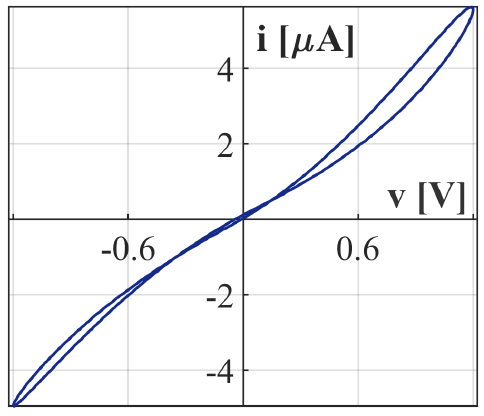
Fig. S1 | Alternating current (AC) voltage-current plot of subject B at the earlobe , shown for the third period of applied sinusoidal voltage with frequency of 0.05 Hz and amplitude of 1.2 V. These data (not shown before) are obtained from the experiment presented in [22]. The two pinched points are indication that the stratum corneum memristor (in parallel with the capacitive properties of the stratum corneum) is dominating the measurement and that the galvanic contact through the sweat ducts was not given (see